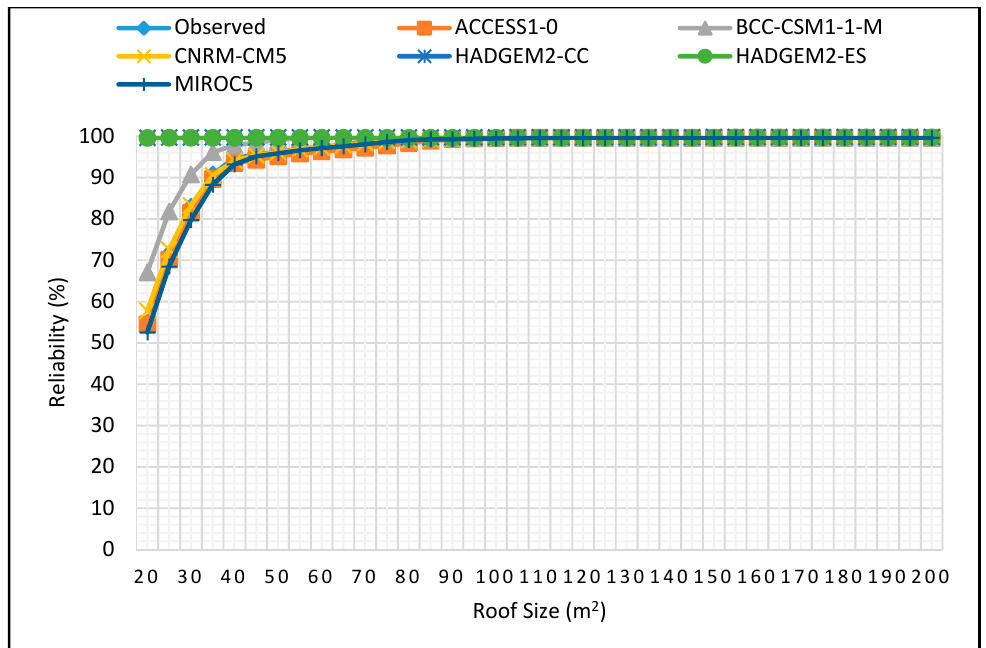
Figure 39. Reliability projections for SON season for 5 m 3 tank size for the 2060–2090 period.